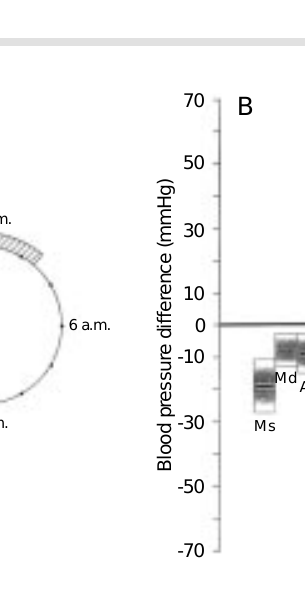
rophase displayed on clock